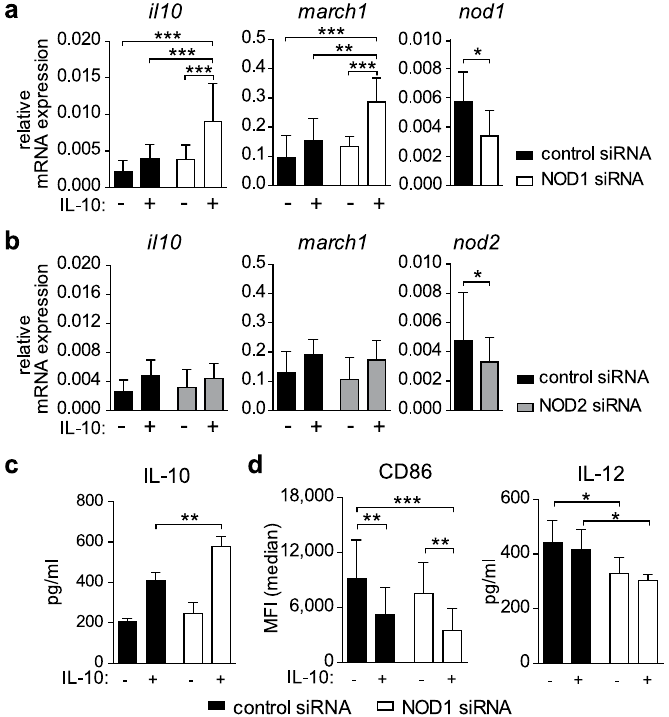
Figure 1. NOD1 silencing promotes il10 and march1 expression and decreases CD86 and IL-12 levels. ( a/b ) Immature DCs were generated and transfected with a control siRNA or siRNA directed against NOD1 ( a ) or NOD2 ( b ). 72 hours post transfection, cells were analysed for silencing efficiency or stimulated with IL-10 (30 ng/ml), and IL-10 target gene expression was monitored 2 hours post IL-10 induction. Data represent mean and SD of at least four independent experiments. ( c ) After 3 days of control or NOD1 silencing, DCs were induced with IL-10 for 4 hours. Cells were re-plated and cultured in fresh medium without IL-10 for 48 hours. IL-10 secretion was analysed after 48 hours by ELISA. Data represent mean and SD of four independent experiments. ( d ) 48 hours post IL-10 stimulation, CD86 expression and IL-12 secretion of control or NOD1 silenced DCs were evaluated by flow cytometry and ELISA, respectively. Data represent mean and SD of at least five independent experiments. For statistical analysis a one-way ANOVA with Tukey’s post hoc test was